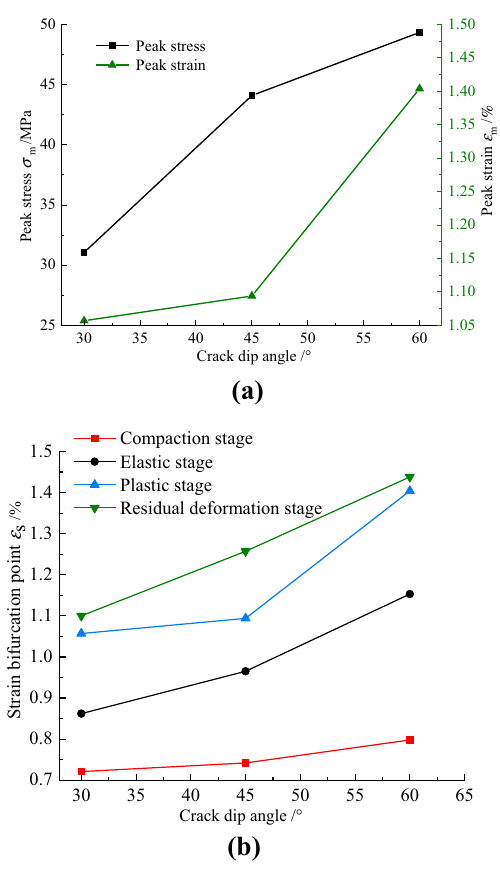
Fig. 4 Peak stress and strain curves of precracked specimens: a peak strength and strain; b strain at each dividing point between different